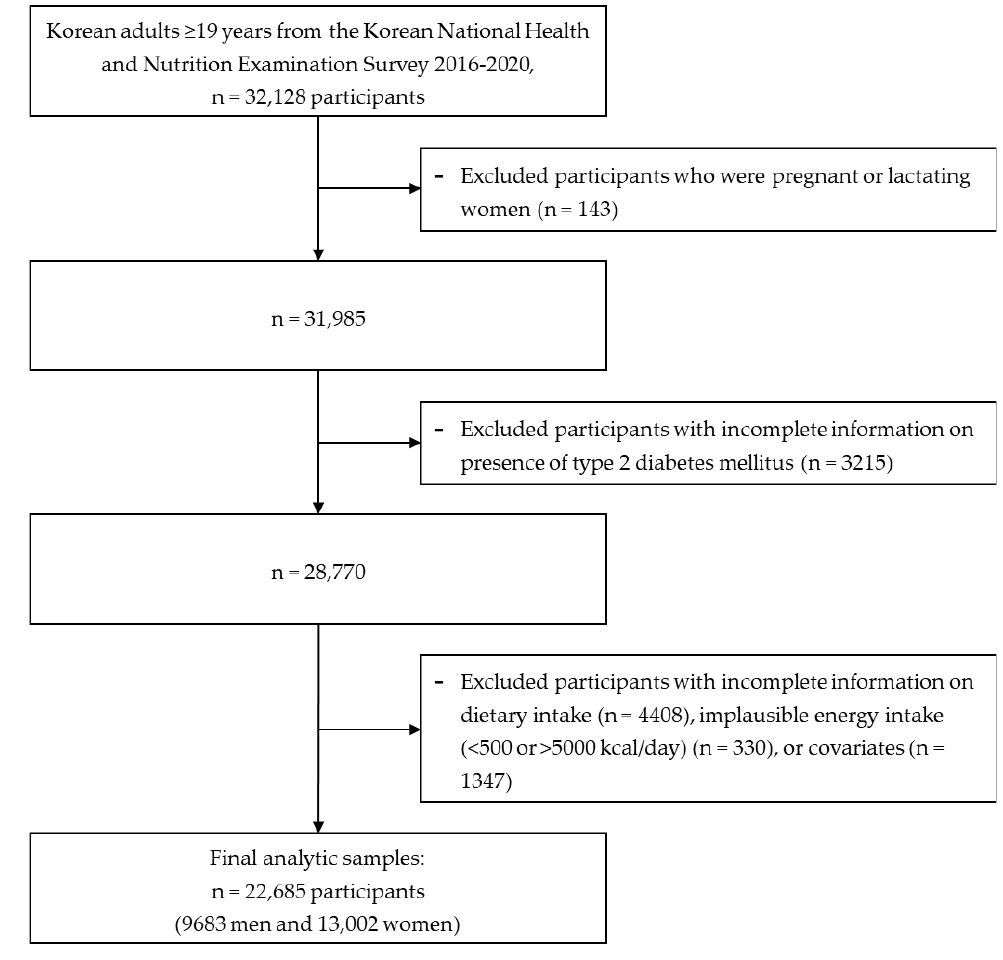
Figure 1. Flow diagram of the study population.